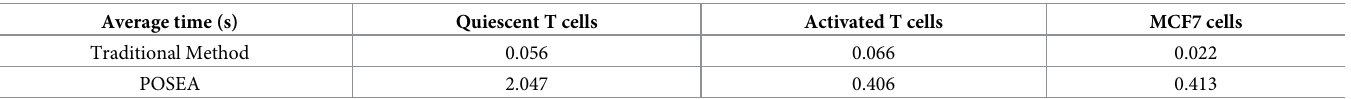
Table 4. Average (n = 5 images) time consumption of POSEA and the traditional pixel-level method to compare ground truth and segmented images of Quiescent T cells, Activated T cells, and MCF7 cells. The average number of cells per image is 154 for Quiescent T cells, 45 for Activated T cells, and 44 for MCF7